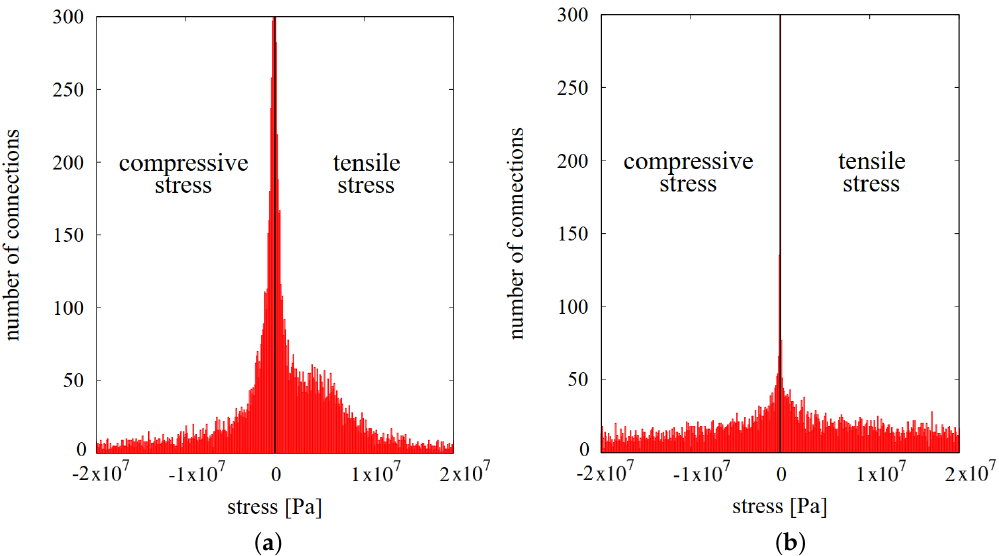
Figure 13. Histograms of total microscopic stresses: ( a ) in the final stage of sintering and ( b ) after sintering (residual microscopic